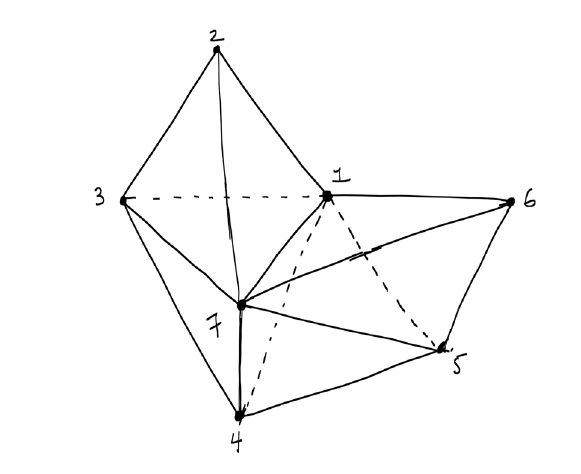
Fig. 6 The amplituhedron, from Arkani-Hamed, N., & Trnka, J., 2014, p.